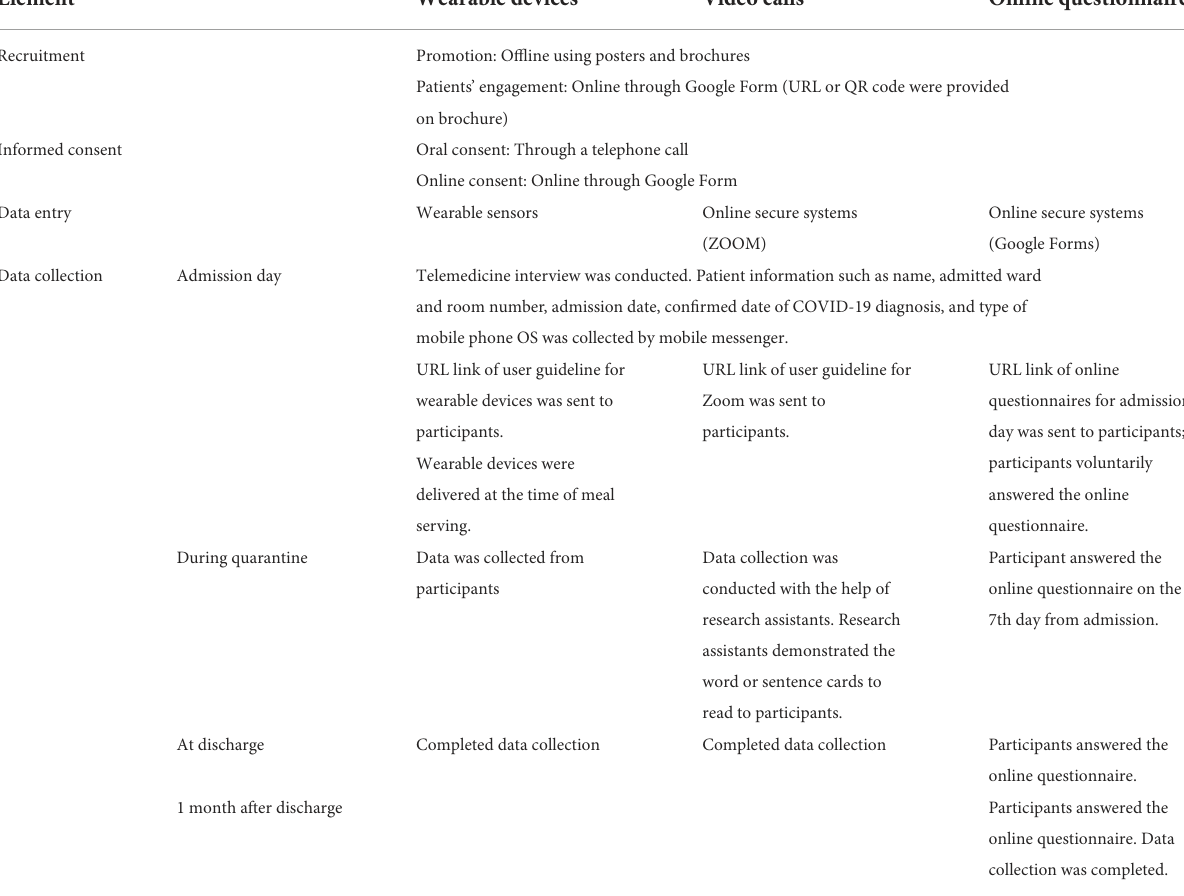
TABLE 1 Elements of the contactless clinical trial using telehealth devices and software.